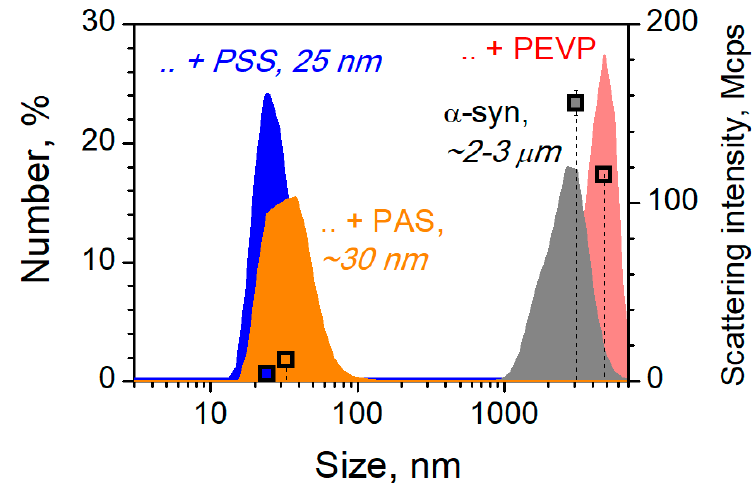
Figure 2. Hydrodynamic diameter of particles formed after 2-day incubation of alpha-synuclein in the absence (gray) and in the presence of 5 mM PSS (blue), PAS (orange) or PEVP (pink). Squares represent scattering intensity, the color and position of each square coincide to those of the corresponding hydrodynamic diameter distribution peak.